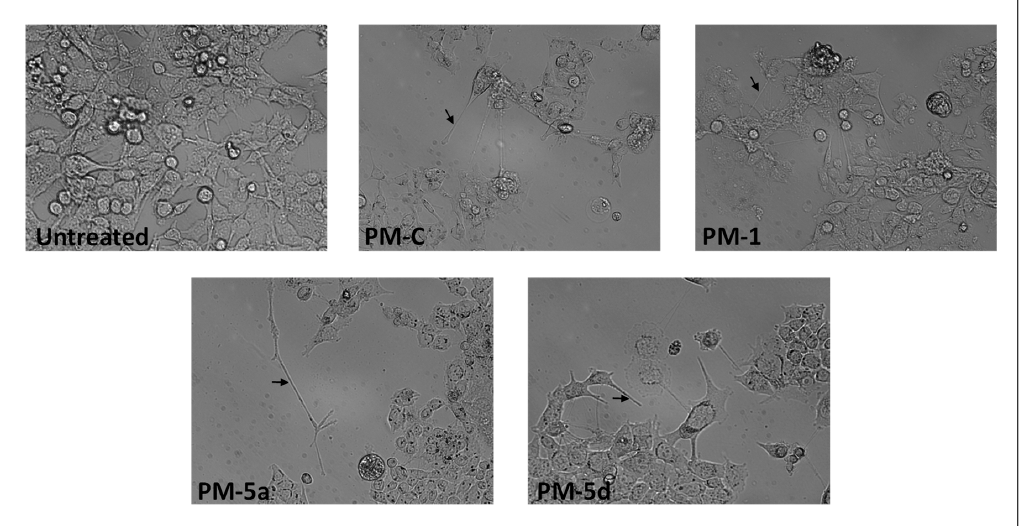
Figure 5. Inverted phase-contrast micrographs of HCT116 cells treated for 24 h with 0.1 µ M of selected PMs. Black arrows indicate cell projection, resembling filopodia Magnification 200 ×